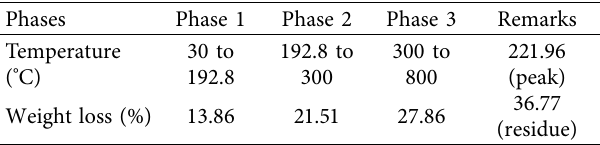
Table 4: Different stages of the TGA for Eucheuma cottoni .